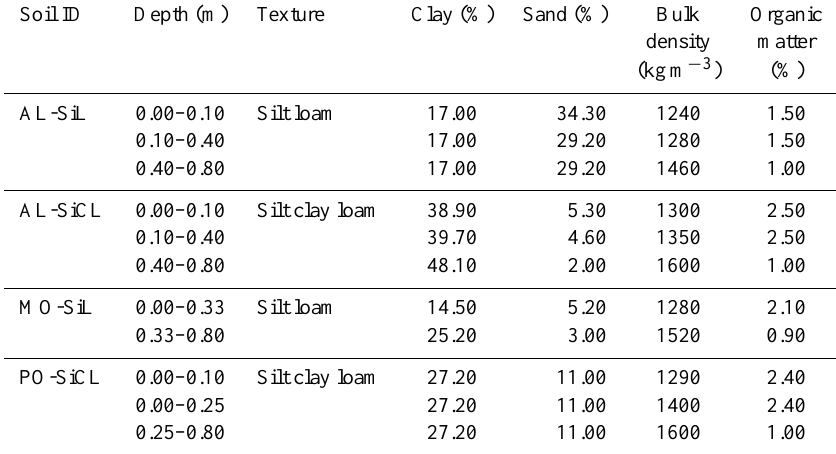
Table 4. Soil characteristics for comparative study, from Chanzy et al.